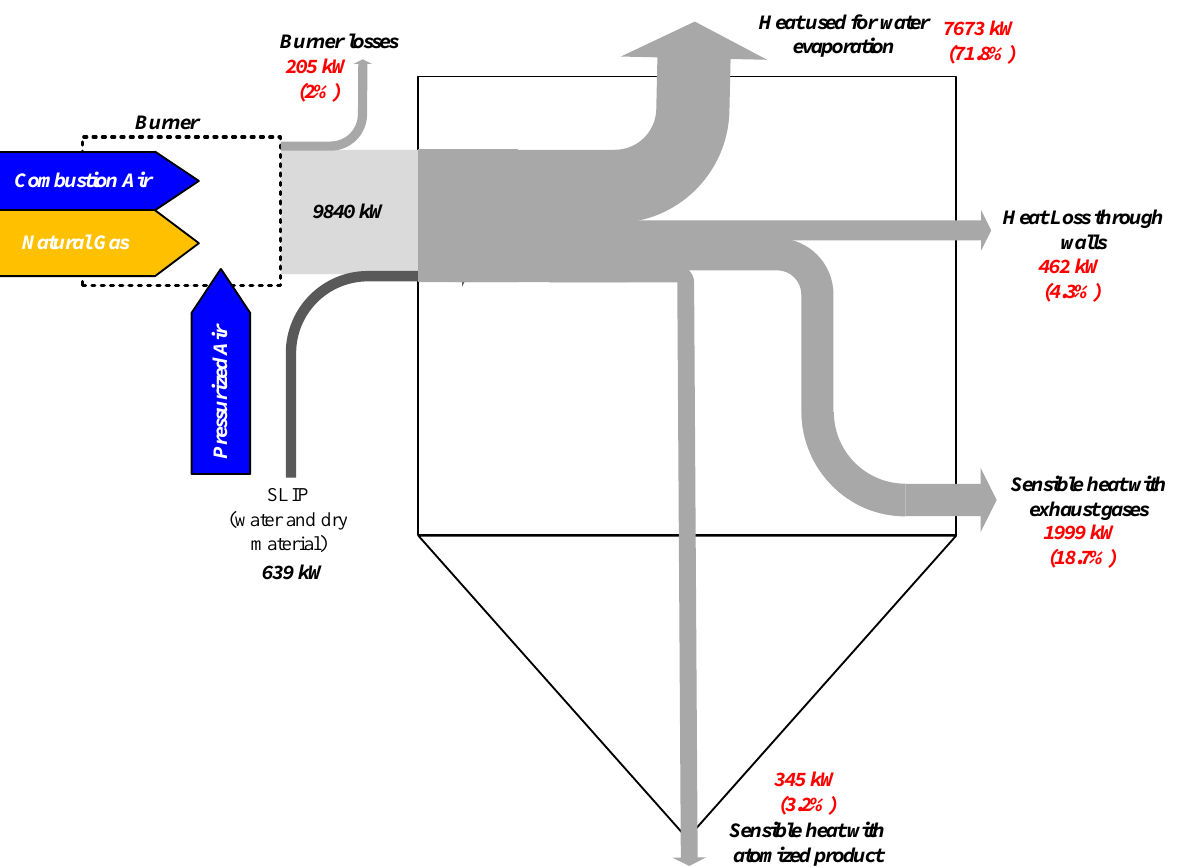
Figure 4. Sankey diagram of the ATM110 spray dryer